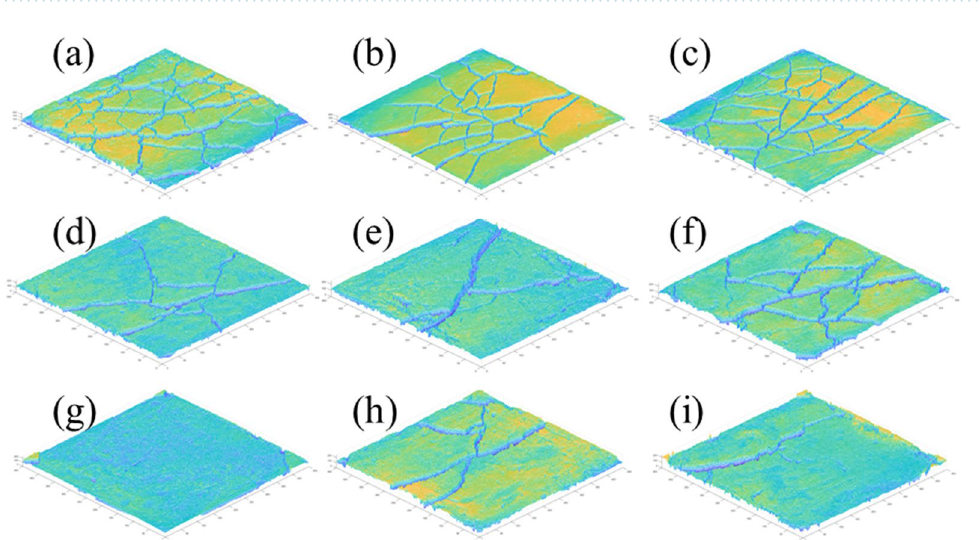
Figure 7. Image processing flow.